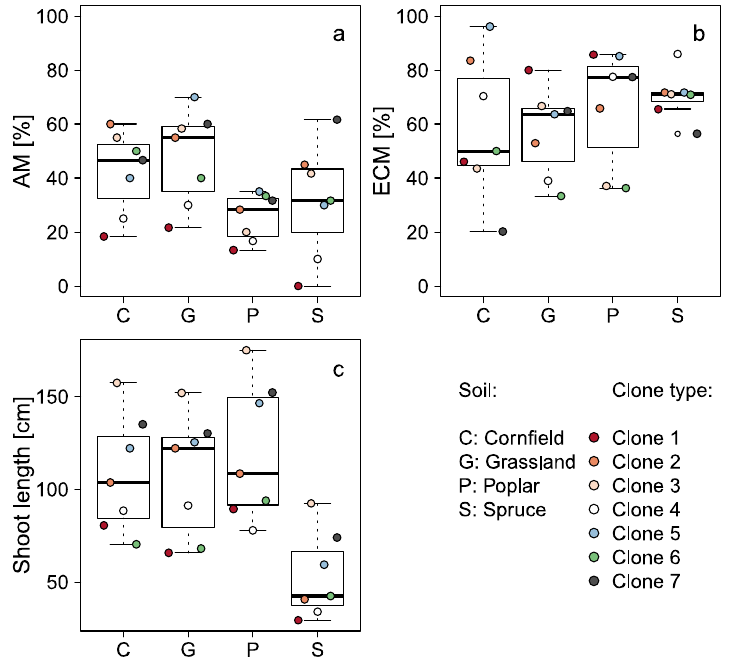
Figure 2. The degree of AM colonization (% in 10 cm root length) ( a ); ECM colonization (% in 20 min sampling) ( b ); and shoot length ( c ) of seven poplar clones in the four different land use types (C = cornfield, G = grassland, P = poplar soil, S = spruce soil). The shoot length and the rate of AM colonization varied significantly among sites and poplar clones. (C1 = P. nigra (clone Fritzlar 2 Maserpappel); C2 = P. deltoids ; C3 = P. nigra × P. maximowiczi (clone Max 3); C4 = P. trichocarpa ; C5 = P. maximowiczii C6 = P. canadensis (clone ROBUSTA); C7 = P. maximowiczii × P. trichocarpa (clone Hybride 275